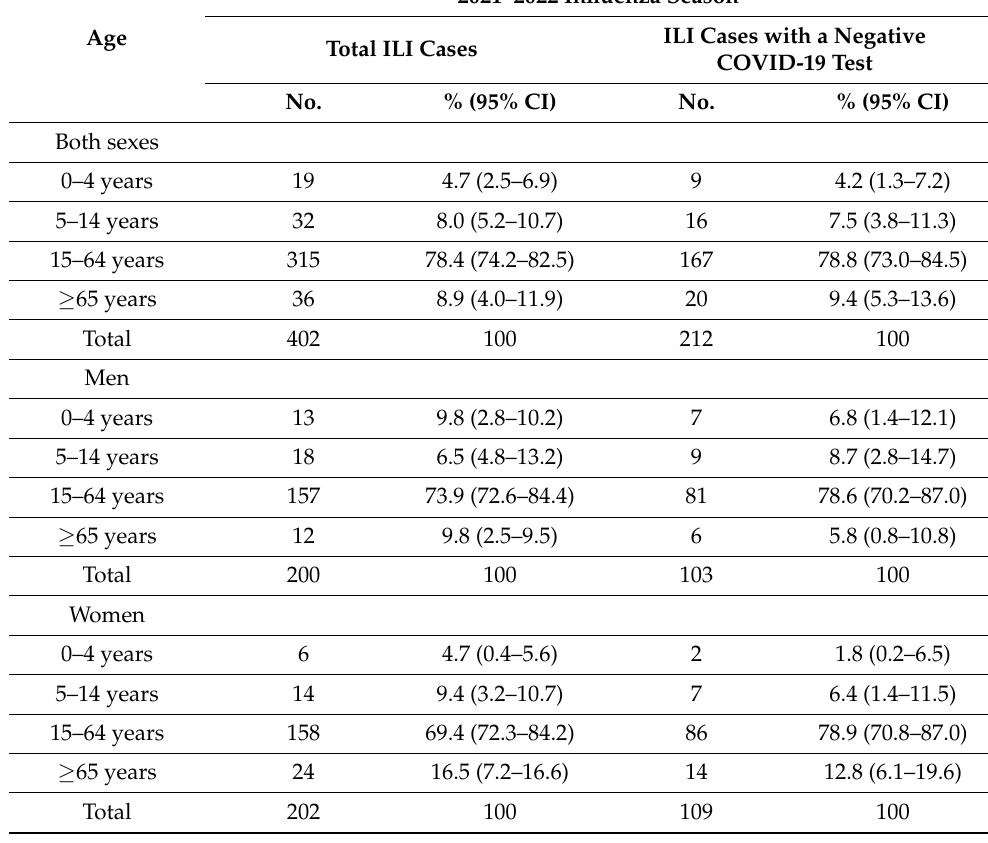
Table 1. Distribution of total influenza-like illness cases (ILI) and influenza-like illness cases with a negative COVID-19 test reported by sentinel pharmacies in Catalonia (Spain) in the 2021–2022 in- fluenza season. Influenza-Like Illness Cases Reported by Sentinel Pharmacies in the 2021–2022 Influenza Season ILI Cases with a Negative Age Total ILI Cases COVID-19 Test No. % (95% CI) No. % (95% CI) Both